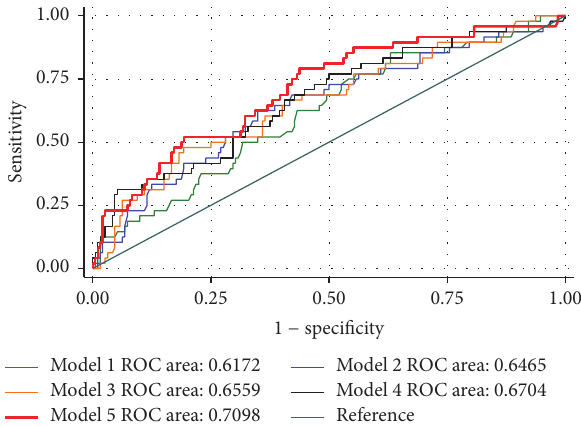
Figure 2: Comparison of ROC area among different models.